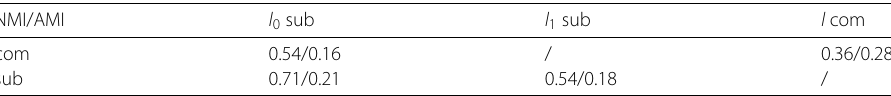
Table 3 NMI and AMI between the partitions by the roles from the sales data (columns) and those from the recipe data (rows), where “com” and “sub” correspond to the complement roles and the substitute roles, respectively NMI/AMI l 0 sub com 0.54/0.16 0.71/0.21 0.54/0.18